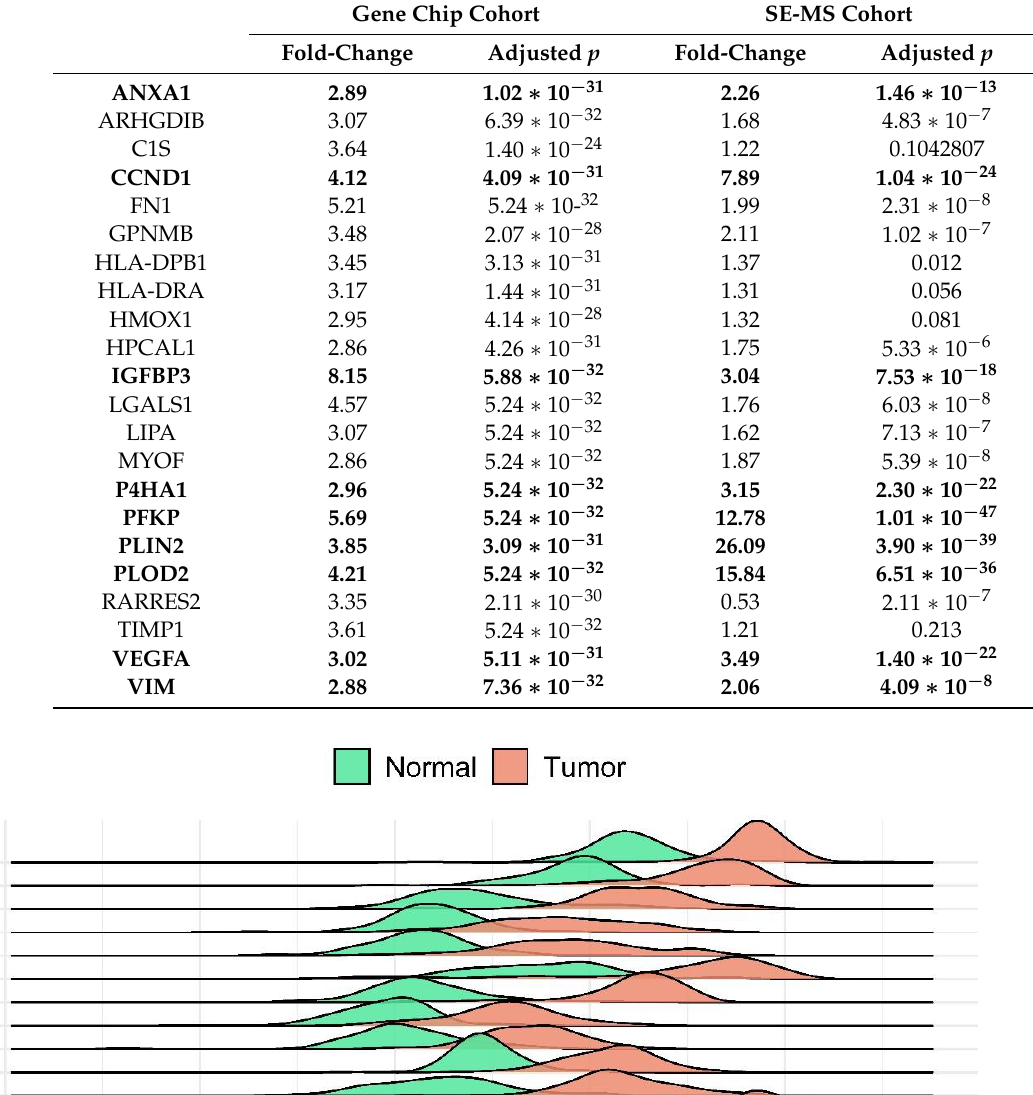
Table 2. Summary table of differential expression analysis of the twenty genes reaching significance in all cohorts. The nine genes used in the final SVM model building to detect ccRCC are highlighted with bold.